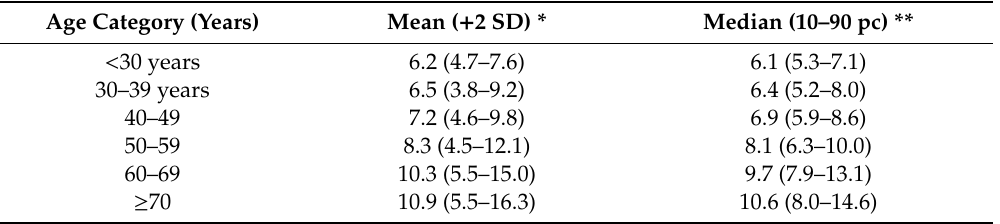
Table 1. PWV reference values (m / s) in the general population according to the age